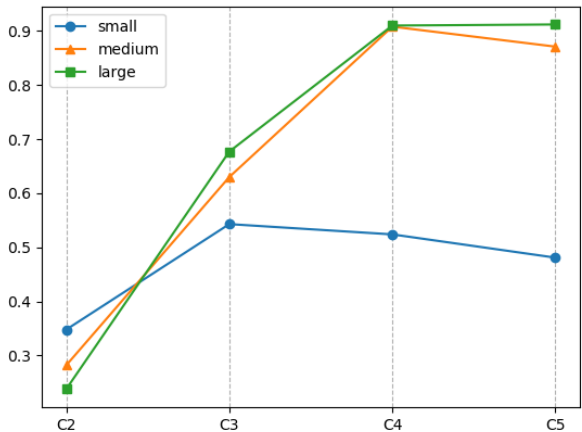
Figure 7. The detection accuracy of ship targets of different sizes is affected by changes in convolution feature depth. The ordinate represents the AP value; the abscissa represents the depth of the convolution feature. C2, C3, C4, and C5 represent the convolution features output by the 11th, 23rd, 41st, and 50th layers,